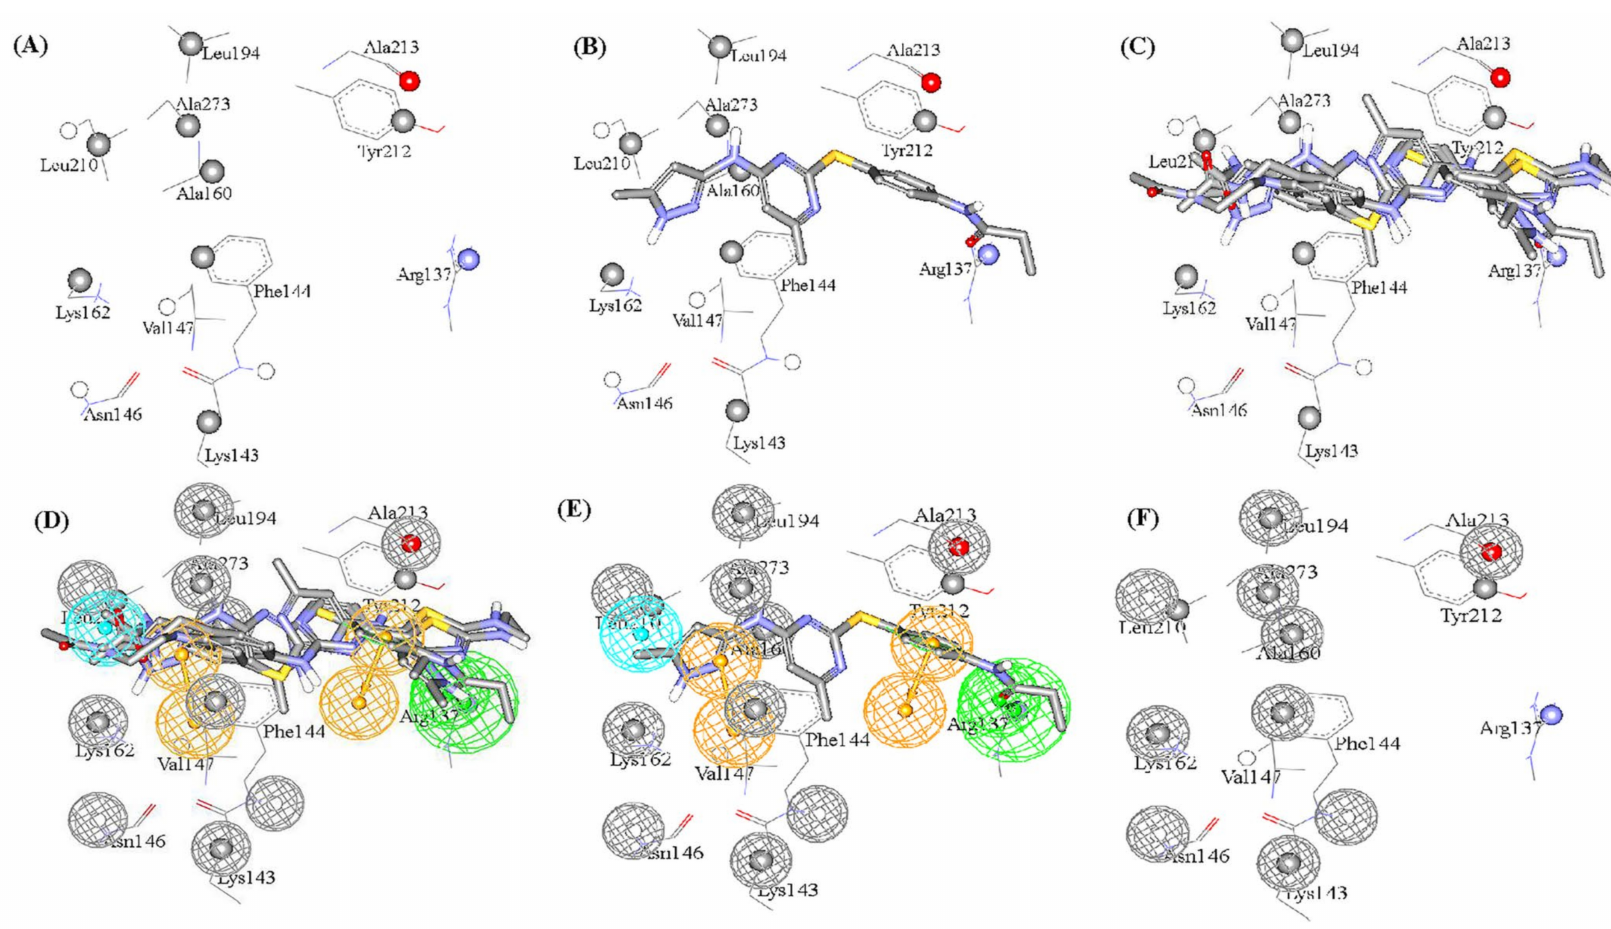
Figure 3. Steps for manual generation of binding model Hypo(SB-1) as guided by dbCICA model SB-1 (Tables 1 and 2): ( A ) The binding site moieties selected by dbCICA model SB-1 with significant contact atoms shown as spheres. ( B ) The docked pose of well-behaved compound 52 (Ki = 5.1 nM) within the binding pocket. ( C ) The docked poses of the well-behaved compounds 50, 52, 71, and 77. ( D ) Manually placed pharmacophoric features onto chemical moieties common among docked well-behaved compounds 50, 52, 71, and 77. ( E ) The docked pose of 52 and how it relates to the proposed pharmacophoric features. ( F ) Exclusion spheres fitted against binding site atoms showing negative correlations with bioactivity (as emergent in dbCICA model